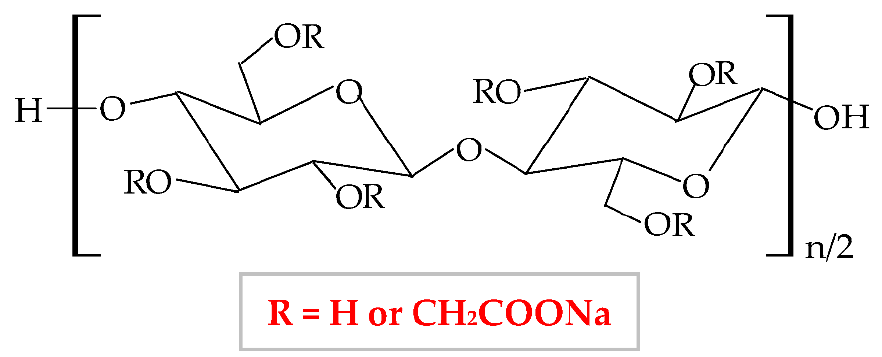
Figure 7. Chemical structure of sodium carboxymethylcellulose (NaCMC).